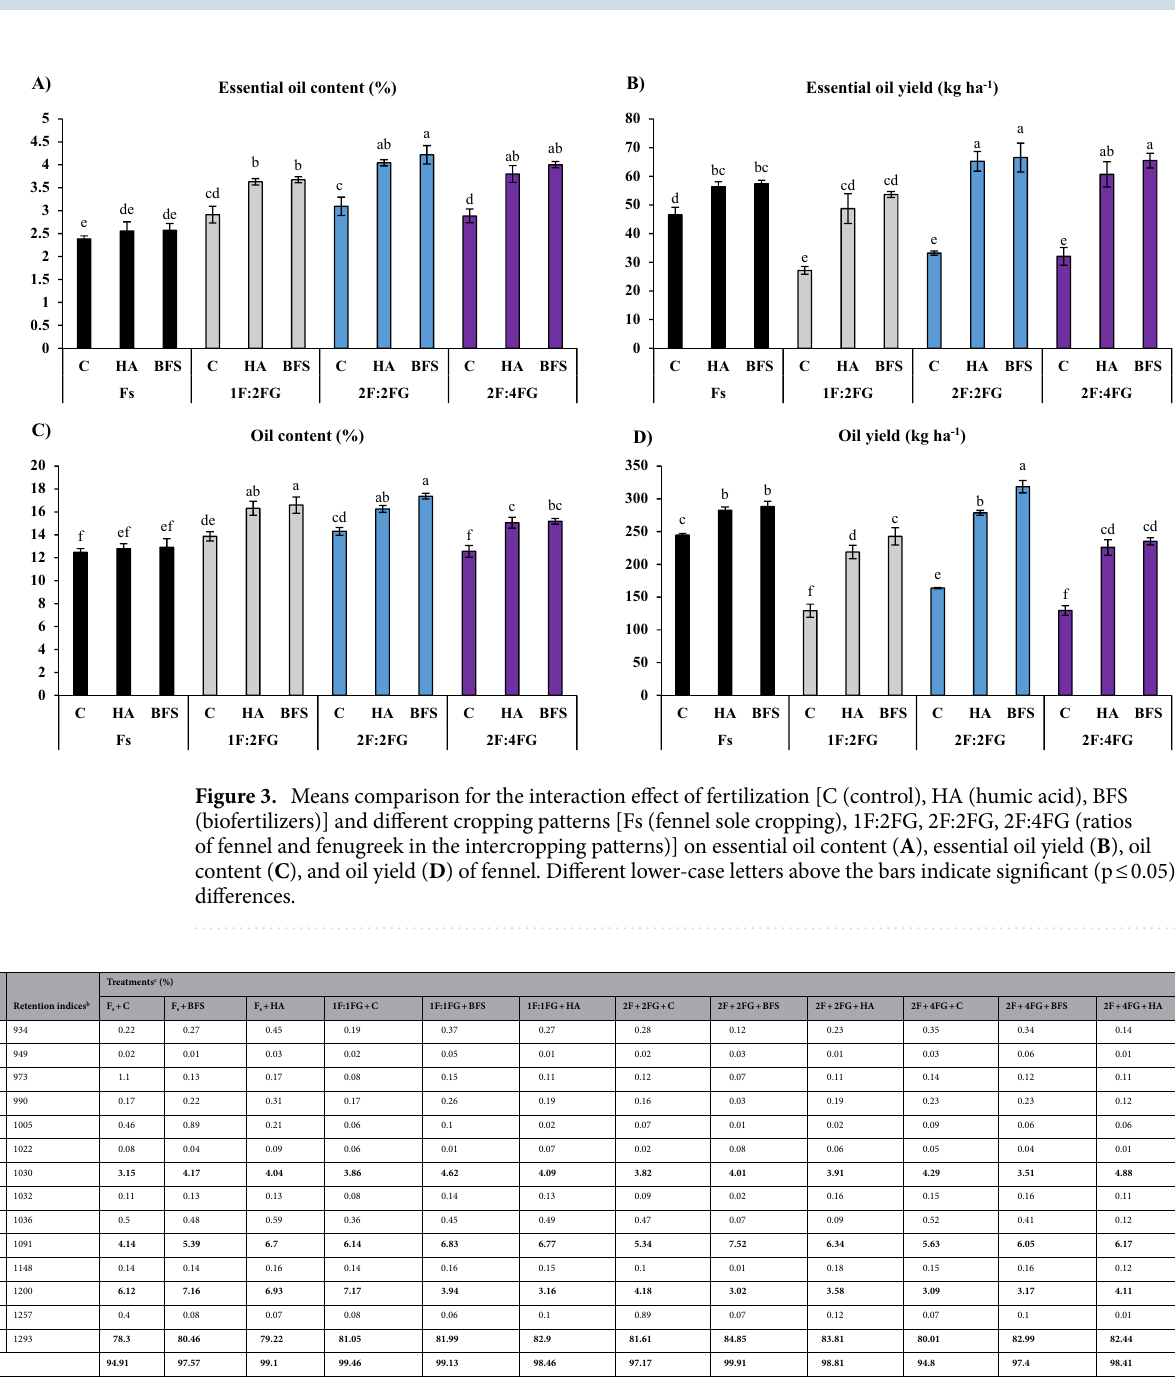
Table 3. Proportion of fennel essential oil constituents under different cropping patterns and fertilization. The main components are shown in bold. a Identification methods: MS, comparison of the mass spectrum with those of computer mass libraries Wiley, Adams and NIST 08; RI, comparison of retention index with those reported in Adams and NIST 08. b RI, linear retention indices on DB-5 MS column, experimentally determined using homolog series of n-alkanes. c C (control), BFS (biofertilizers), HA (humic acid), and Fs (fennel sole cropping), 1F:2FG, 2F:2FG, and 2F:4FG are the ratios of fennel and fenugreek in the intercropping